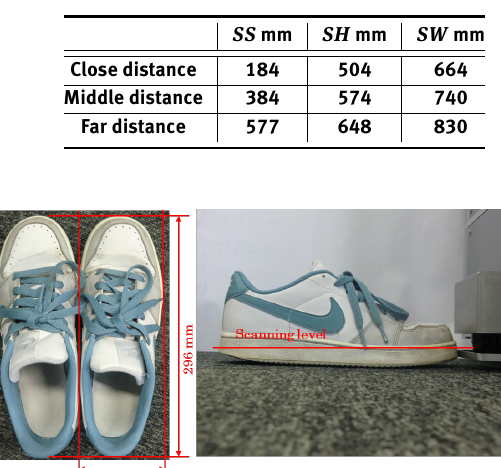
(C) Experimental Result: The result in forward direction is shown in Figure 19. The center of the forefoot circle C ffi (cid:0) x ffi , y ffi (cid:1) , i = 0 to 9 is de- tected by the program. The center of the hindfoot circle C bfi (cid:0) x bfi , y bfi (cid:1) is obtained using Equation (1). Figure 19(a) shows the position error between C bfa , which is the aver- age of measured position C bfi , and C b , which is the cen- ter of hindfoot circle of the footmark. Figure 19(b) shows (cid:12) (cid:12) the direction error, (cid:12) α ′ − α (cid:12) , as the average and standard deviation. The result in backward direction is shown in Figure 20. Figure 20(a) shows the position error between C ffa , which is the average of measured position C ffi , and C f , which is the center of forefoot circle of the footmark. Fig- (cid:12) (cid:12) ure 20(b) shows the direction error, (cid:12) α ′ − α (cid:12) , as the average and standard deviation. From these results, we can find that the average of po- sition errors are less than 40 mm and the average of direc- tion error and its standard deviation are less than 15 deg